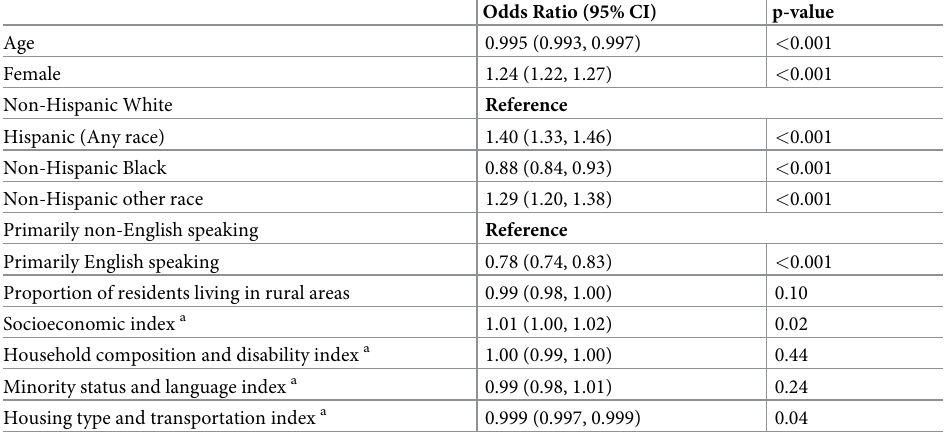
a. Sub-component of the CDC Social Vulnerability Index (SVI) based on Centers for Disease Control and Prevention methodology [9]. Higher value of SVI sub-component indicates greater degree of social vulnerability of an area to a health